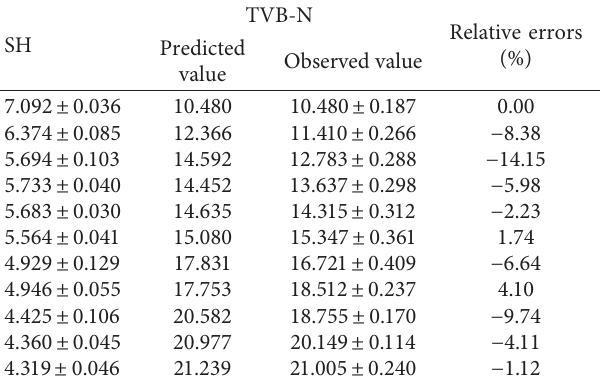
Data are mean ± SD ( n �